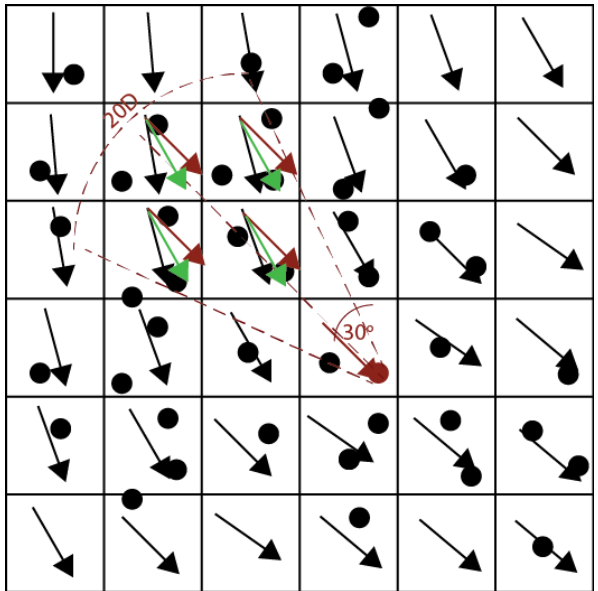
Figure 2. Example of how the wind direction variability within the farm is treated in the Jensen wind farm parameterization. The wind turbines are black circles, and the turbine of interest is red. The black arrows are the wind vectors at the grid cells; the red arrow is the wind vector at the grid cell of interest, replicated at the relevant upstream grid cells; and the green arrows are the average of the wind direction at the grid cells and that at the grid cell of